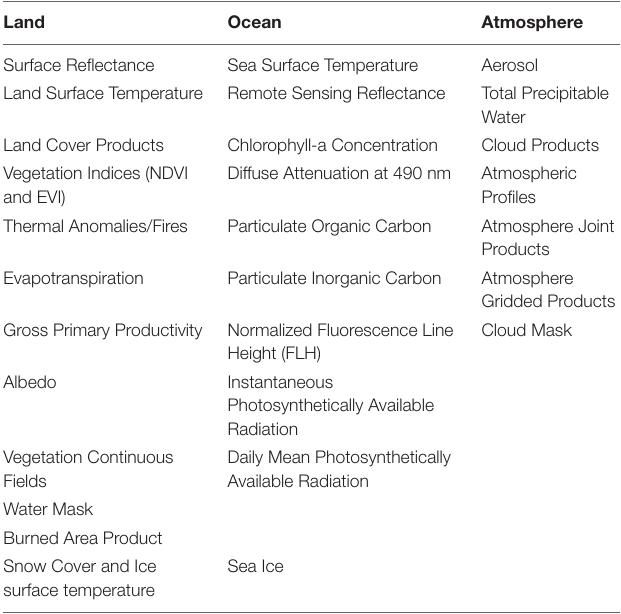
TABLE 5 | Available products from